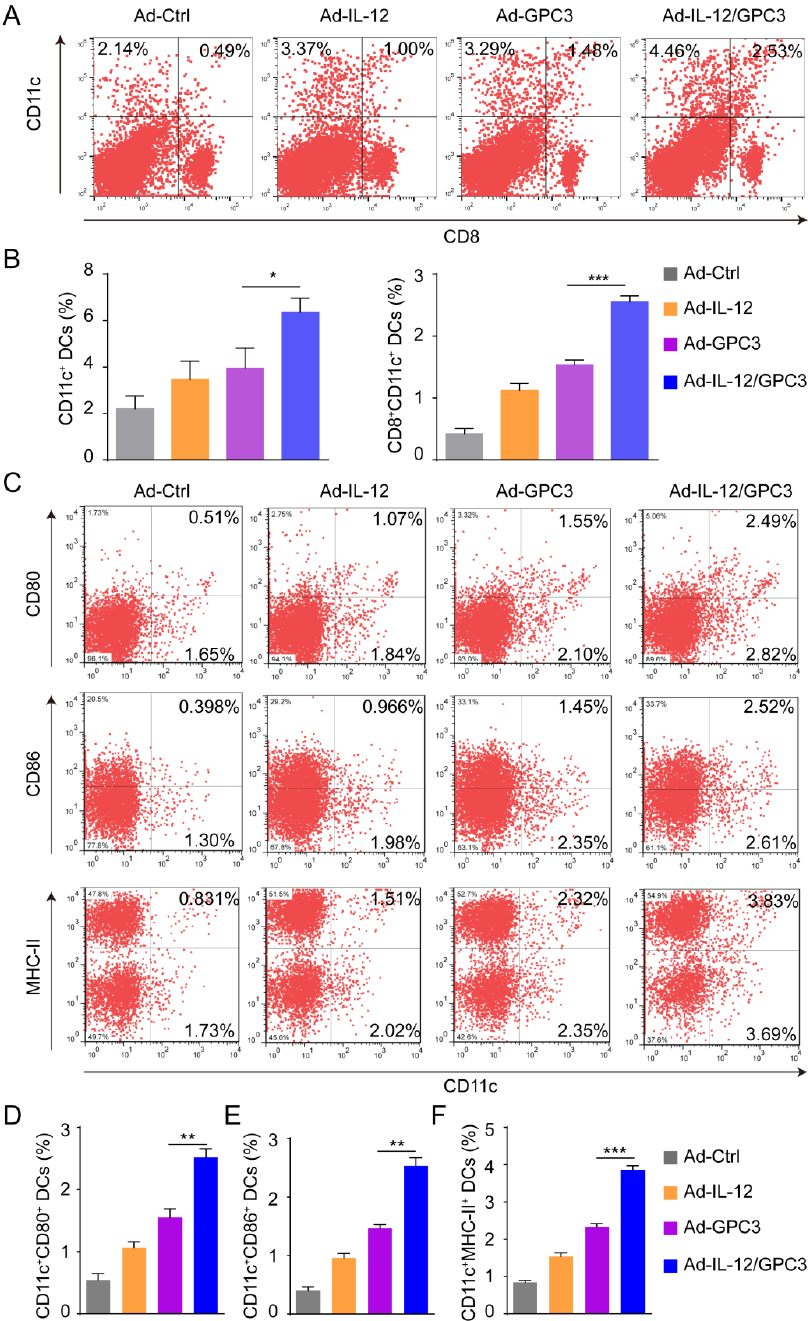
Figure 3. Enhancement of Ad-IL-12/GPC3 vaccine on recruitment and maturation of CD11c + DCs and CD8 + CD11c + DCs subset. 42 days after tumor inoculation, spleen cells were isolated from immunized mice, and analyzed by flow cytometry. ( A ) The proportion of splenic CD11c + DCs or CD8 + CD11c + DCs subset. A representative result of flow cytometry was shown. ( B ) Statistical analysis of the frequency of splenic CD11c + cells. ( C ) Statistical analysis of the frequency of splenic CD8 + CD11c + subset; ( D ) the frequency of CD80, CD86, or MHC-II expression on CD11c + cells in the spleen. ( E , F ) Statistical analysis of the frequency of CD11c + CD80 + , CD11c + CD86 + or CD11c + MHC -II + cells in spleen. Data are from one representative experiment of three performed and presented as the mean ± SD. The different significance was set at * p < 0.05, ** p < 0.01, and *** p < 0.001.